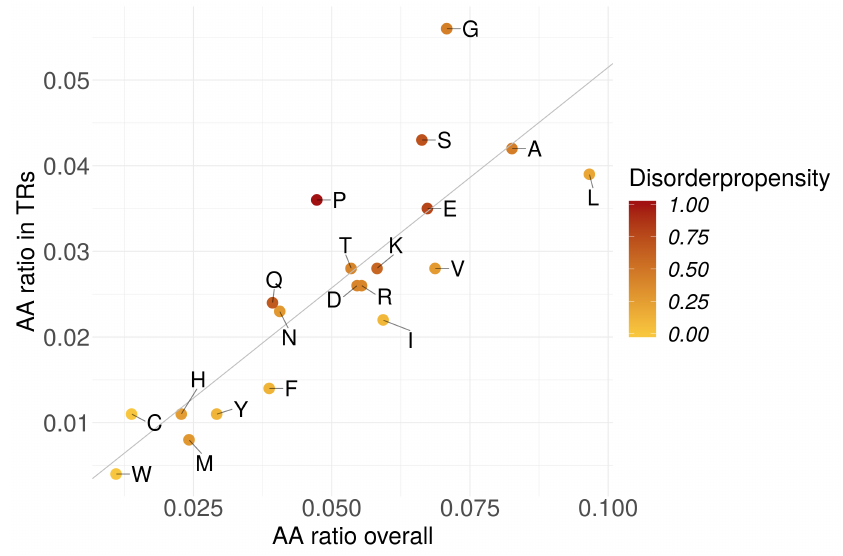
Figure 4. Amino acid frequencies in TRs vs. all proteins normalized by total AA numbers. Darker color indicates higher disorder